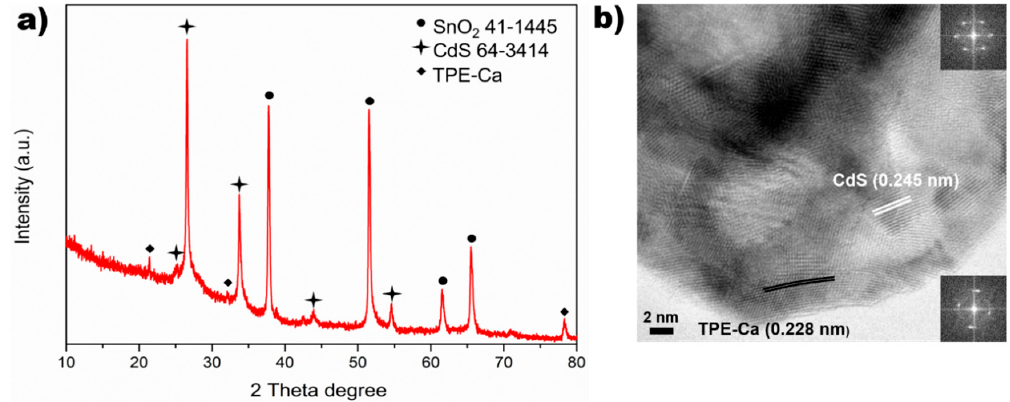
Figure 1. ( a ) The PXRD patterns of the as-prepared CdS/TPE-Ca electrode; ( b ) the HR-TEM and SAED of the CdS/TPE-Ca scrapped from one electrode.